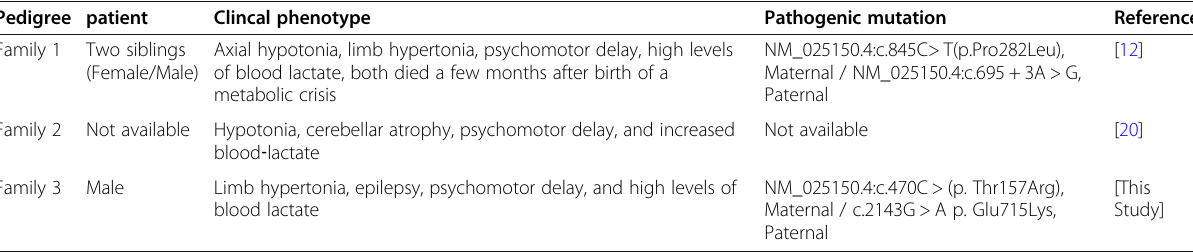
Table 2 Cases with TARS2 mutations including reported and the case in our study Pedigree